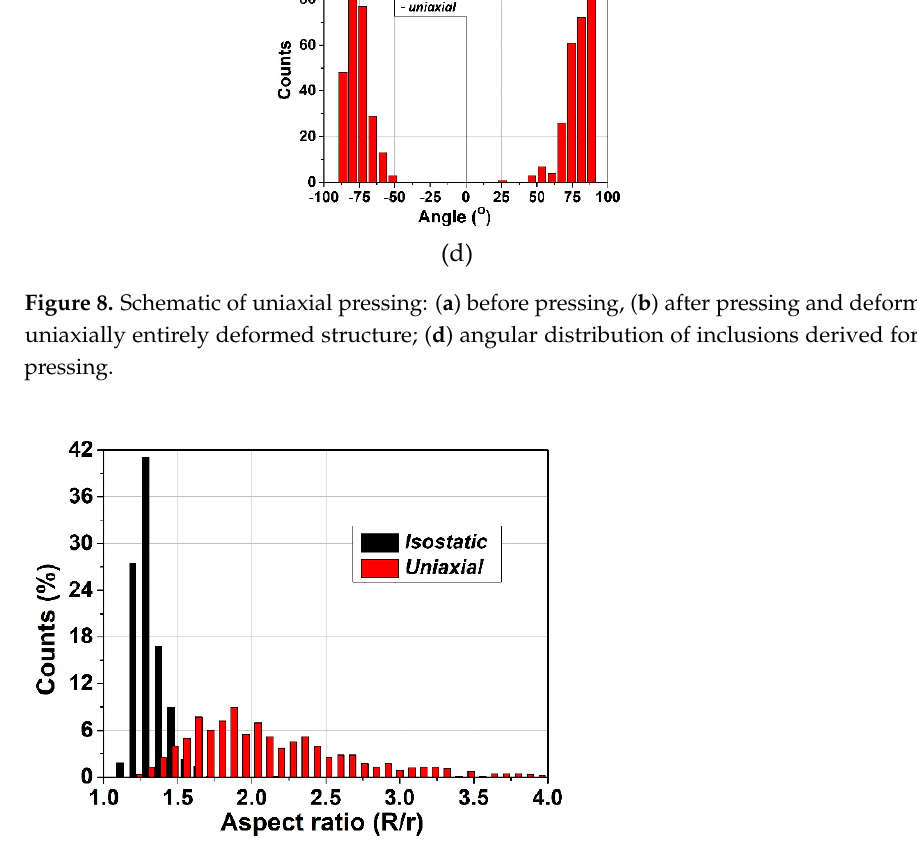
Figure 9. Comparative plot of the aspect ratio distributions of the soft phase for the isostatic and uniaxial pressing.